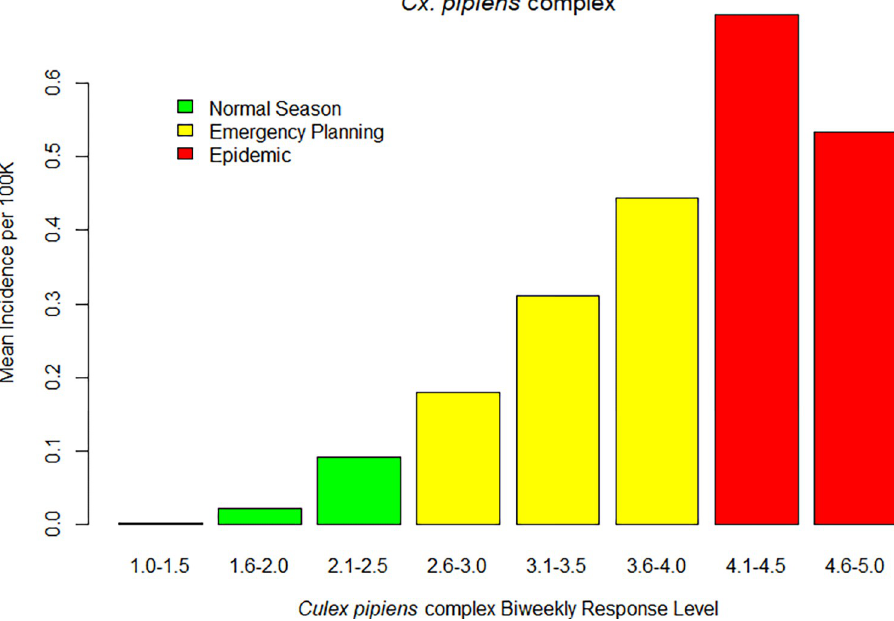
Fig 3. Observed human WNV disease incidence in 3-week periods versus antecedent biweekly overall risk levels, based on temperature, abundance and at least 1 infection indicator, for the Cx . pipiens complex in California, 2009–2018.